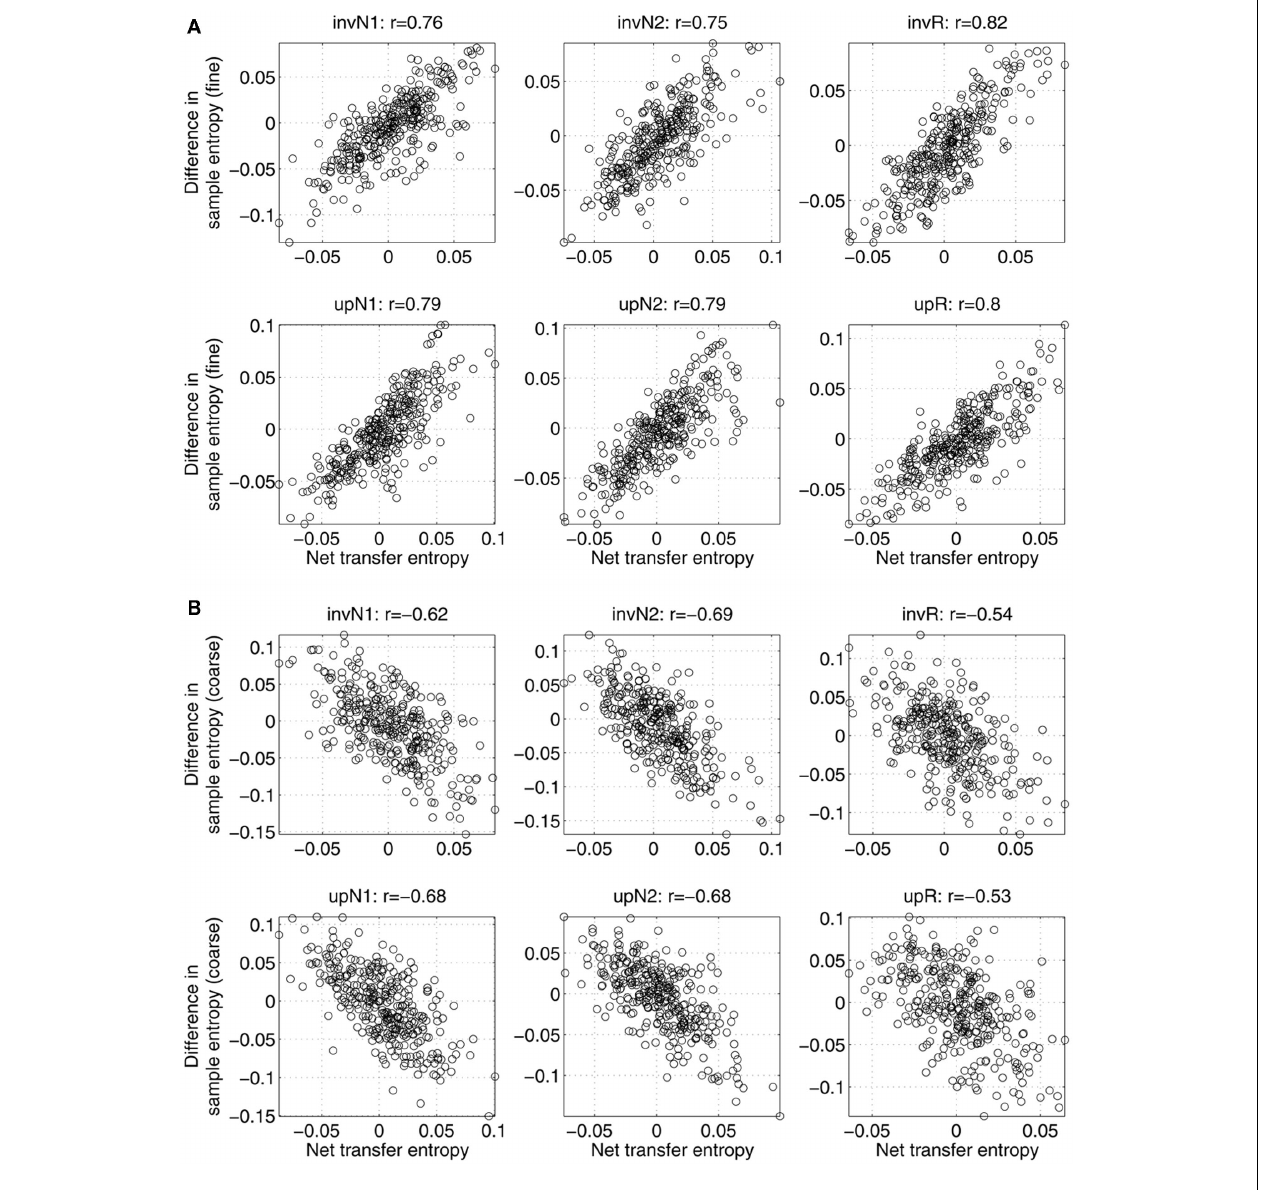
between the two measures (significant for all the conditions with p -values less than 0.001). A positive correlation implies that the net information is transferred from a source with higher sample entropy to a source with lower sample entropy. Negative correlations imply that more information is transferred toward a system with a higher sample